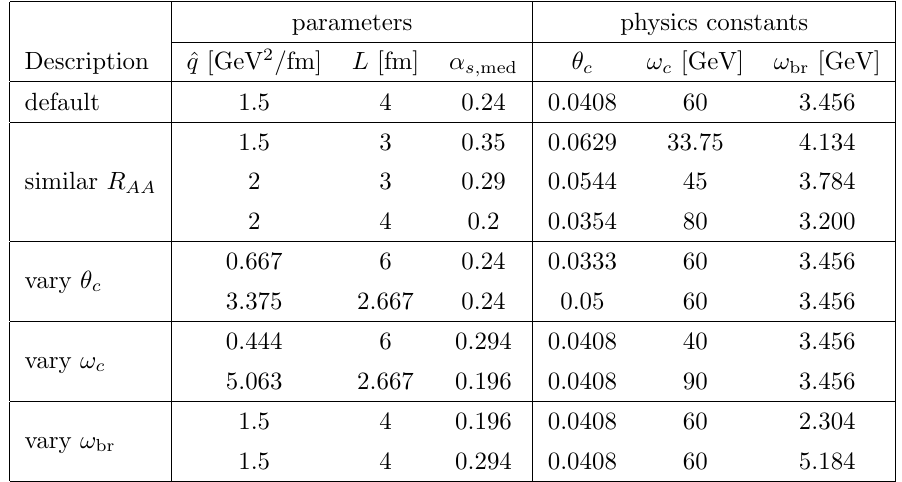
Table 1 . Table of medium parameters used in this paper. The default set of parameters is given in the (cid:12)rst line. The next 3 lines are parameters which give a similar prediction for R AA . The last 6 lines are up and down variations of (cid:18) 2 , ! c and ! br by 50%, keeping the other two physics c constants